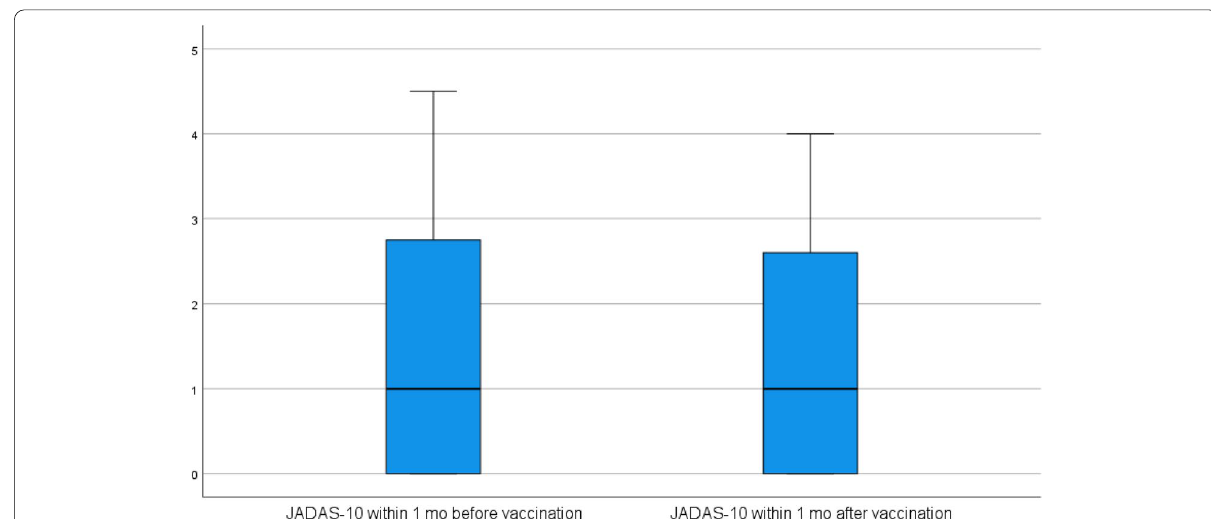
Fig. 1 JIA activity by JADAS-10 score before and after vaccination revealing no flare of the primary disease after